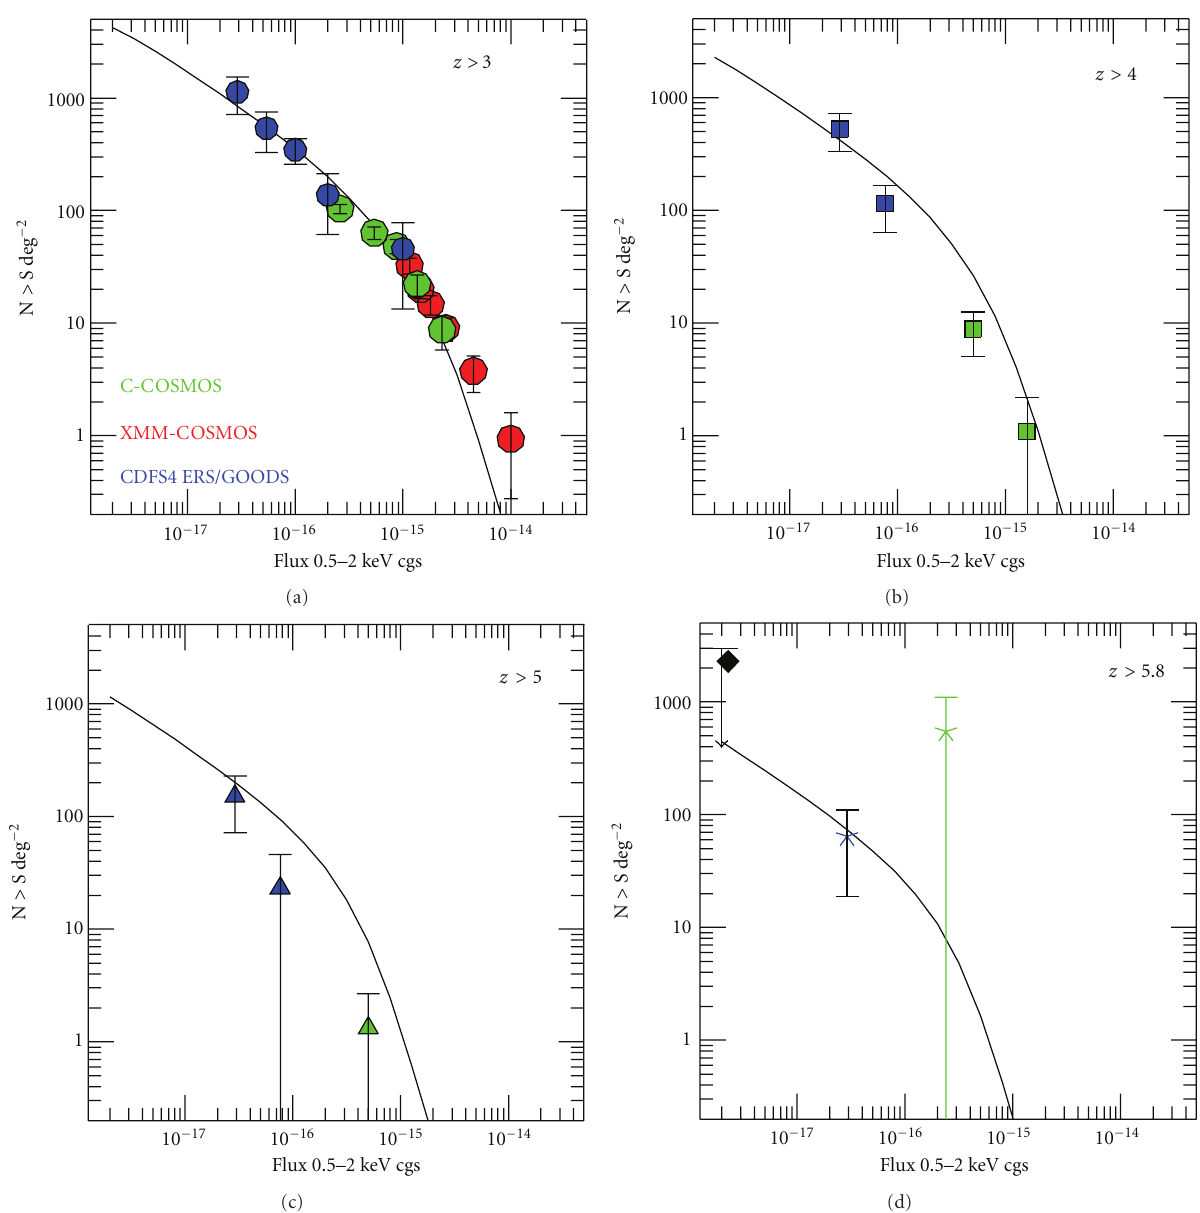
Figure 2: Faint X-ray sources number counts in the 0.5–2 keV band and in four redshift ranges. Blue points are from X-ray detections at the position of ERS and GOODS-MUSIC z > 3 galaxies [9]; green points are from Chandra-COSMOS [23]; red points are from XMM-COSMOS [24]. Circles = z > 3 sources, squares = z > 4 sources, triangles = z > 5, and star = z > 5 . 8 sources. Diamond = Treister et al. determination [18]. The upper limit in the lower right panel is from Table 1. The thin solid curves are model number counts based on the best fit high- z luminosity functions presented in